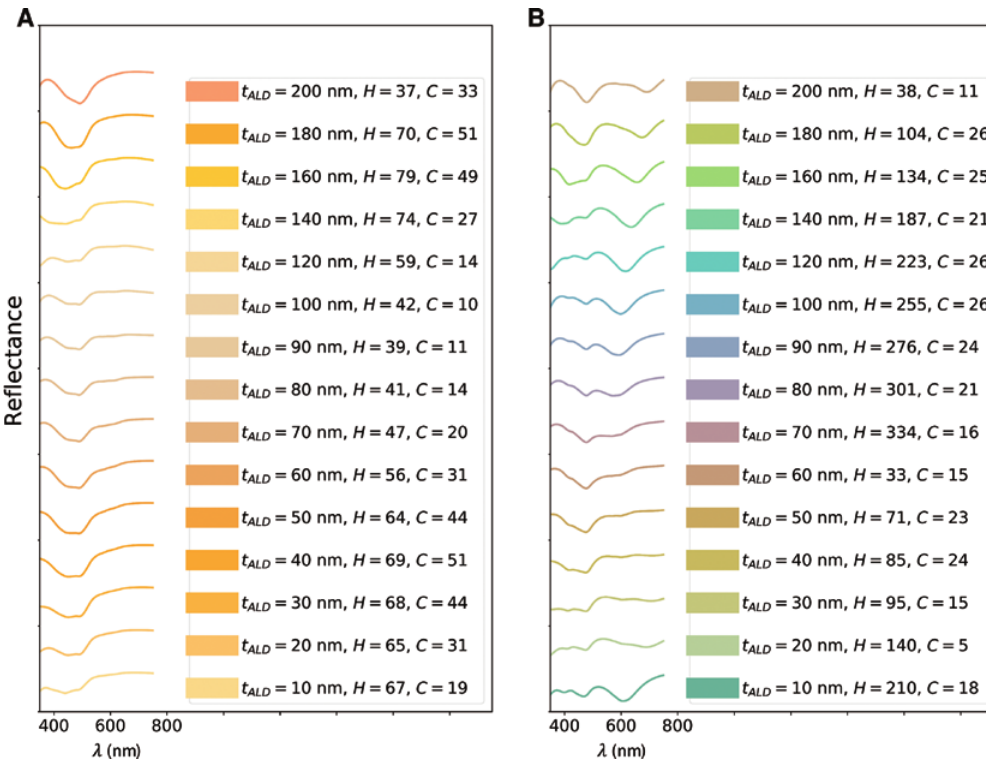
Figure 9: Reflectance spectra and colour evolution for increasing t The simulation setup is R = 35 nm, R A = 150